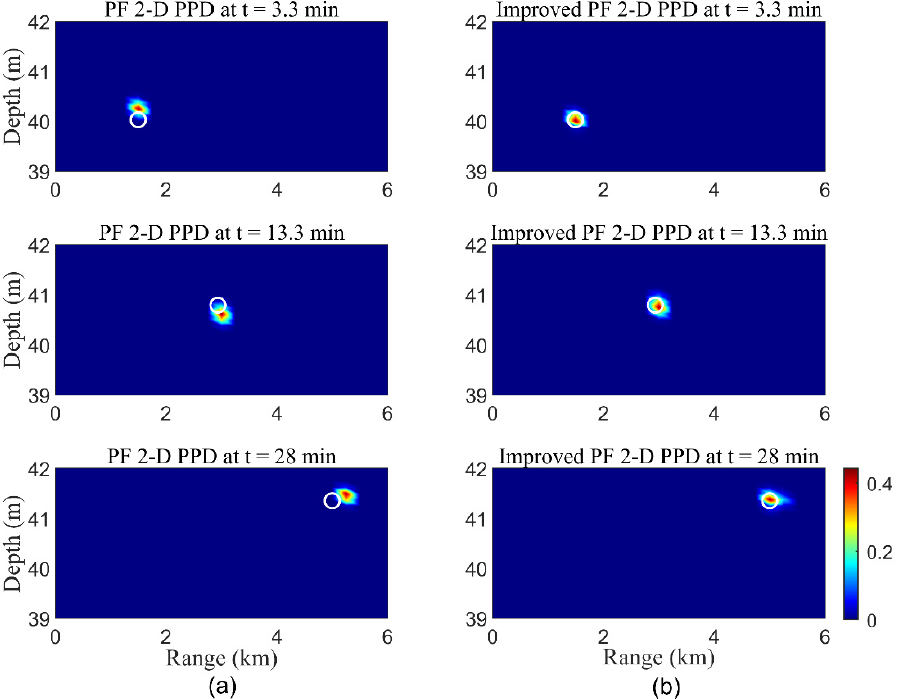
moving source at 3.3, 13.3, and 28 min.  ‘ ’ represents the true source location. Values are in terms source at 3.3, 13.3, and 28 min. ’ (cid:13) ’ represents the true source location. Values are in terms of